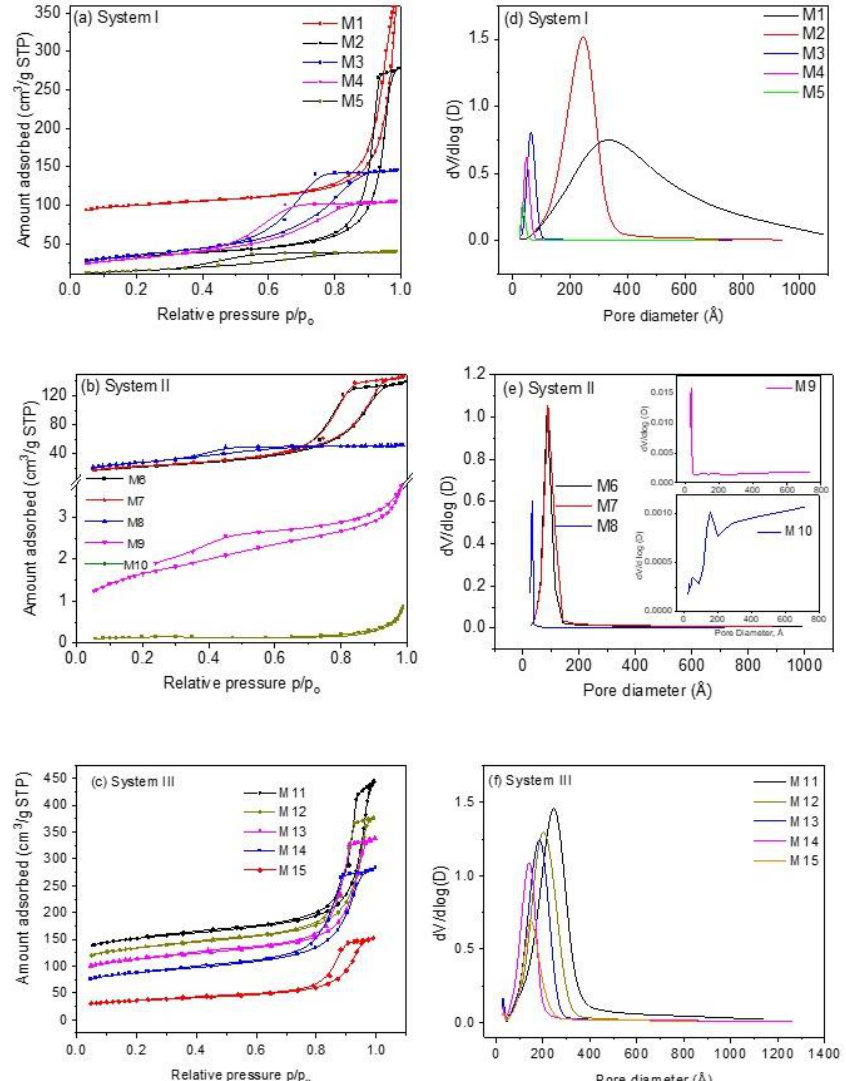
Figure 1. Nitrogen adsorption and desorption isotherms of CoHCFs of ( a ) system I of samples M1–M5; ( b ) system II of samples M6–M10; ( c ) system III of samples M11–M15. Pore size distributions of CoHCFs of ( d ) system I of samples M1–M5; ( e ) system II of samples M6-M-10; ( f ) system III of samples M11 – M15.